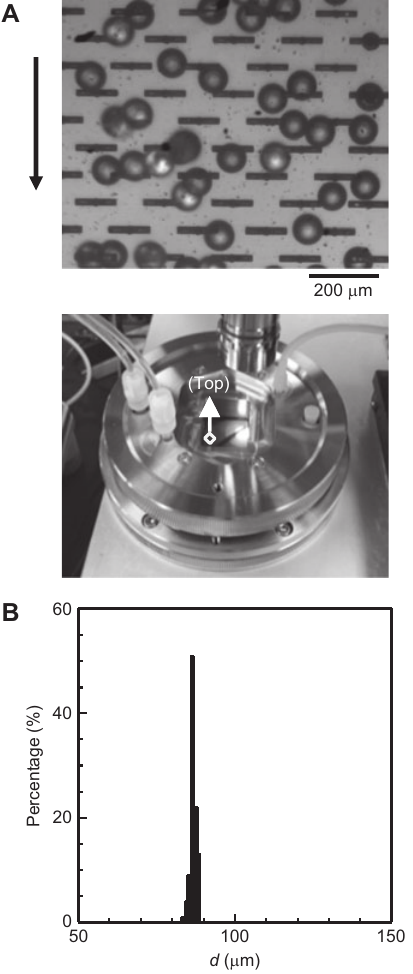
Figure 5 (A) Typical droplet generation result at a dispersed phase volumetric flow rate ( Q ) of 0.15 l/h. (Top) Optical micrograph of the d generation of oil droplets via asymmetric MCs. The arrow denotes the direction of the cross-flowing continuous phase. (Bottom) Top view of the module during MC emulsification. (B) Size distribution of the oil droplets generated using the WMS10